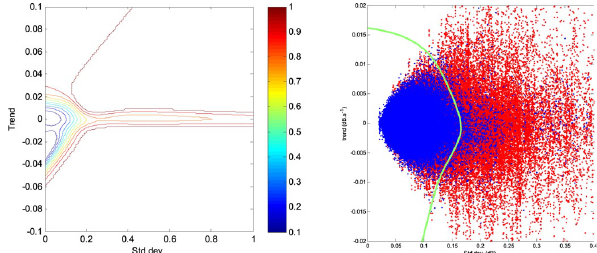
Fig. 7. (a) MLP output: posterior rain class probability. (b) Bound- ary of the classifier (green solid line), samples corresponding to the dry class are in blue, and samples corresponding to the rainy class are in red. Fig. 8. Percentage of rain vs 1-hour accumulated rain threshold for the radar time series (green), rain gauges (red), and KU device (blue), for a threshold P o = 0.55 .